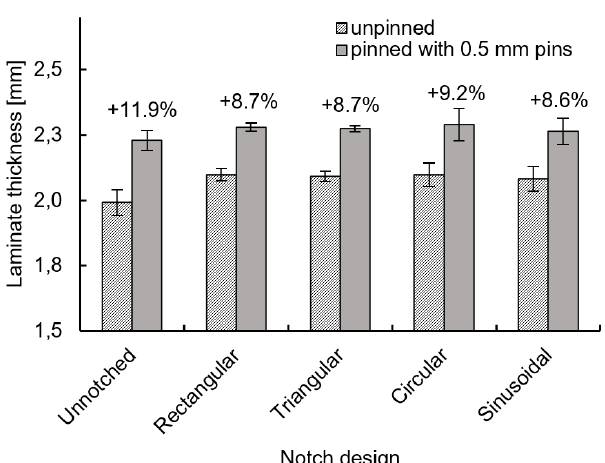
Figure 4. Average values and standard deviation values of laminate thicknesses in the pinned and unpinned areas of the z-pin reinforced specimens with unnotched and notched z-pins with constant notch depth of 20 µ m. The percentage increase of laminate thicknesses of z-pinned areas compared to the areas without pins is also